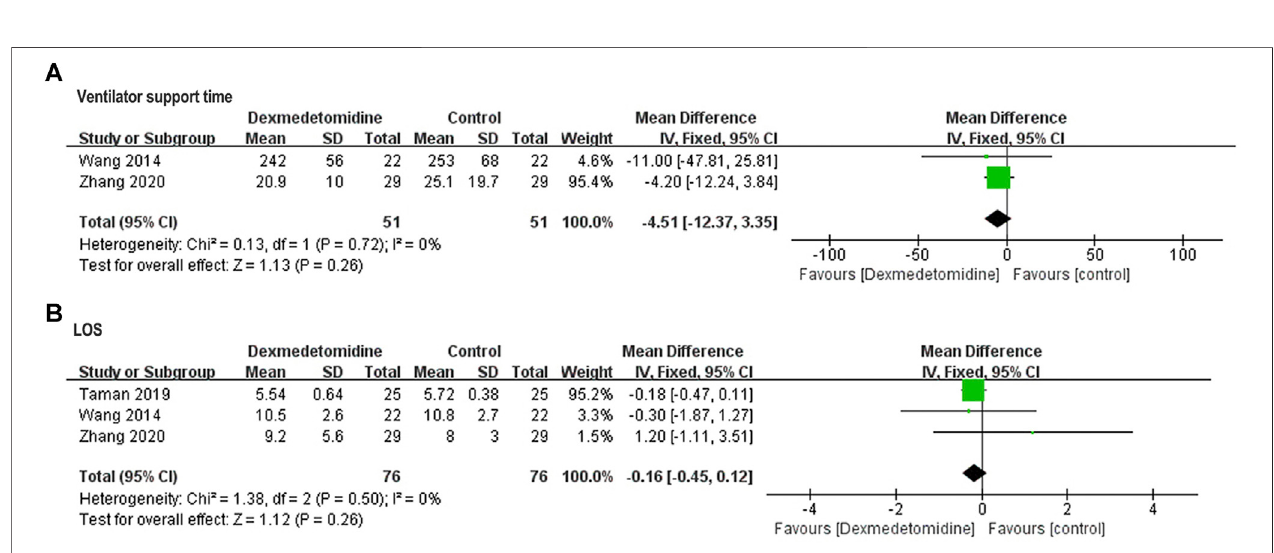
FIGURE 7 | Forest plots for meta-analyses comparing postoperative ventilator support time (A) and LOS (B) .